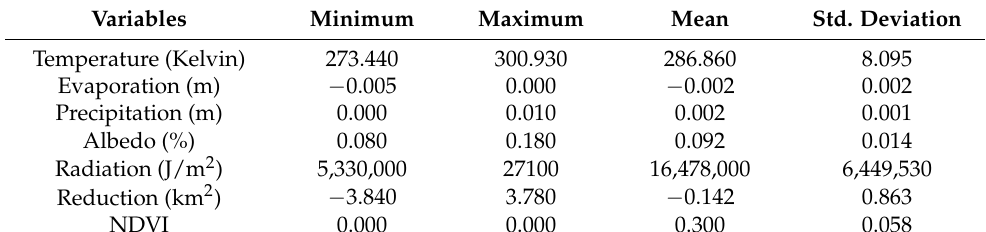
Table 2. Minimum, maximum, mean, and standard deviations for the selected variables.